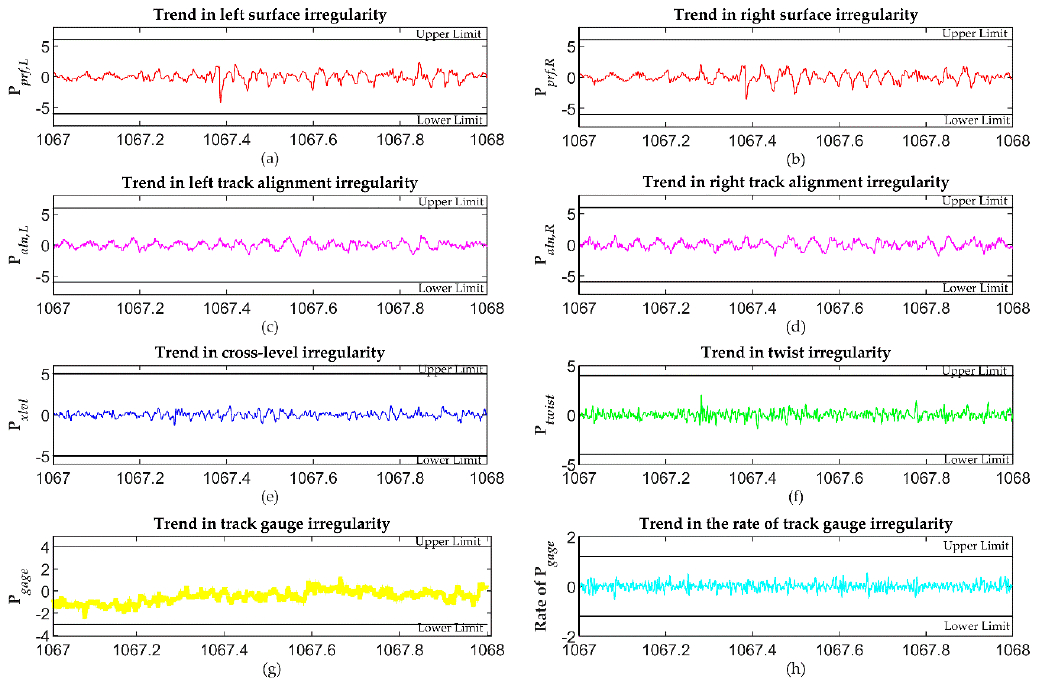
Figure 5. Trend in the geometric parameters from K1067 to K1068 (unit: km): ( a ) Left surface irregularity, ( b ) right surface irregularity, ( c ) left track alignment irregularity, ( d ) right track alignment irregularity, ( e ) cross-level irregularity, ( f ) twist irregularity, ( g ) track gauge irregularity, and ( h ) the rate of track gauge